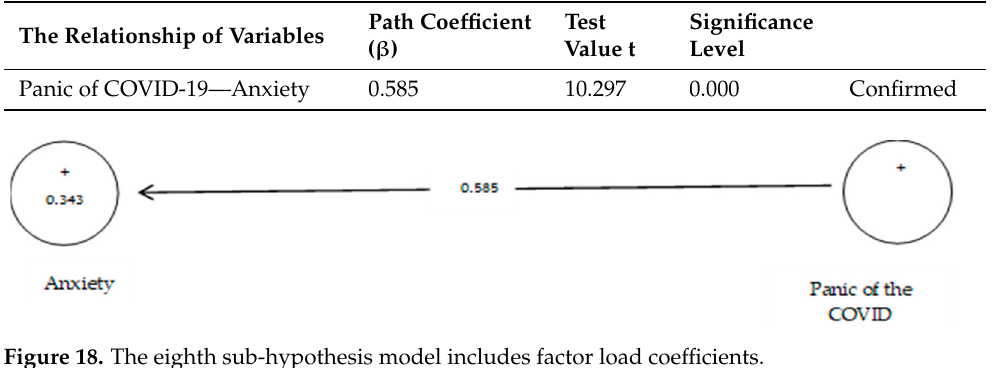
Table 12. Evaluation indicators of the internal model of the research, direction and significance of direct effects.